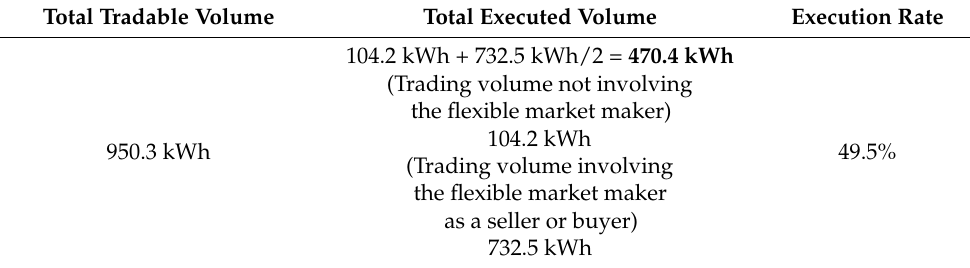
Table 9. Total volumes in the simulation with the flexible market maker.